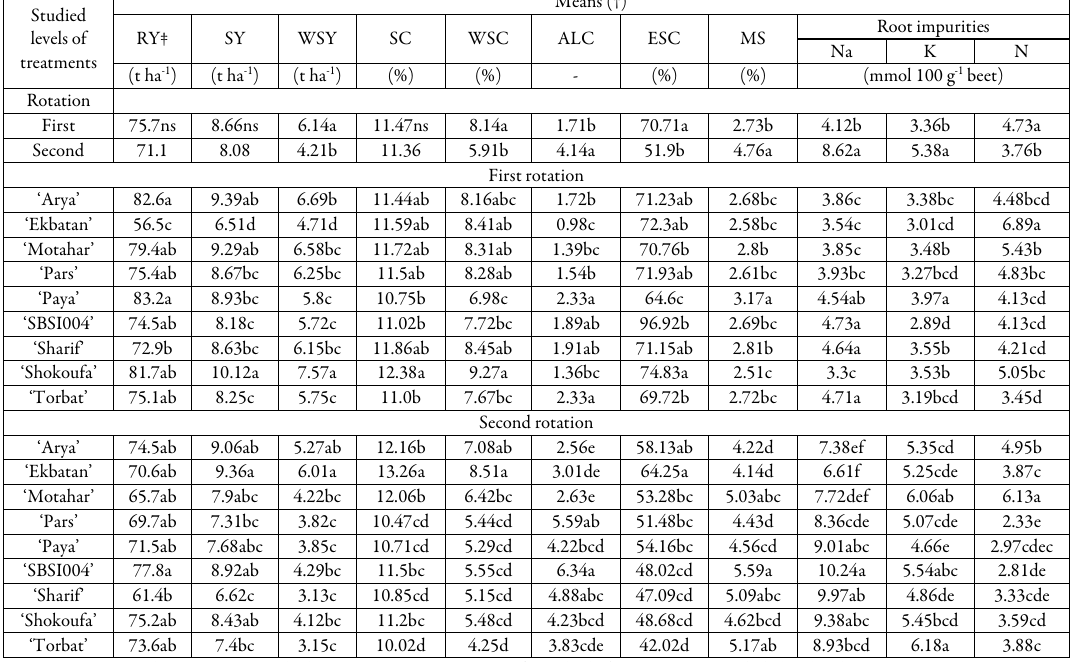
(Table 2). White sugar yield averaged across rotations was lowest in second rotation (4.21 t ha -1 ) and highest in first rotation (6.14 t ha -1 ), with a mean of 5.18 t ha -1 (Table 3). Differences in white sugar yield were primarily owing to differences in white sugar content and not root yield at both rotations. Sugar concentration averaged over rotation s ranged from 11.47% in first rotation to 11.36% in second rotation. No significant difference was observed between two rotations (Table 3). Table 3. Effects of rotation sequences on qualitative and quantitative characteristics of sugar beet cultivars Means (†) Studied levels of treatments Rotation